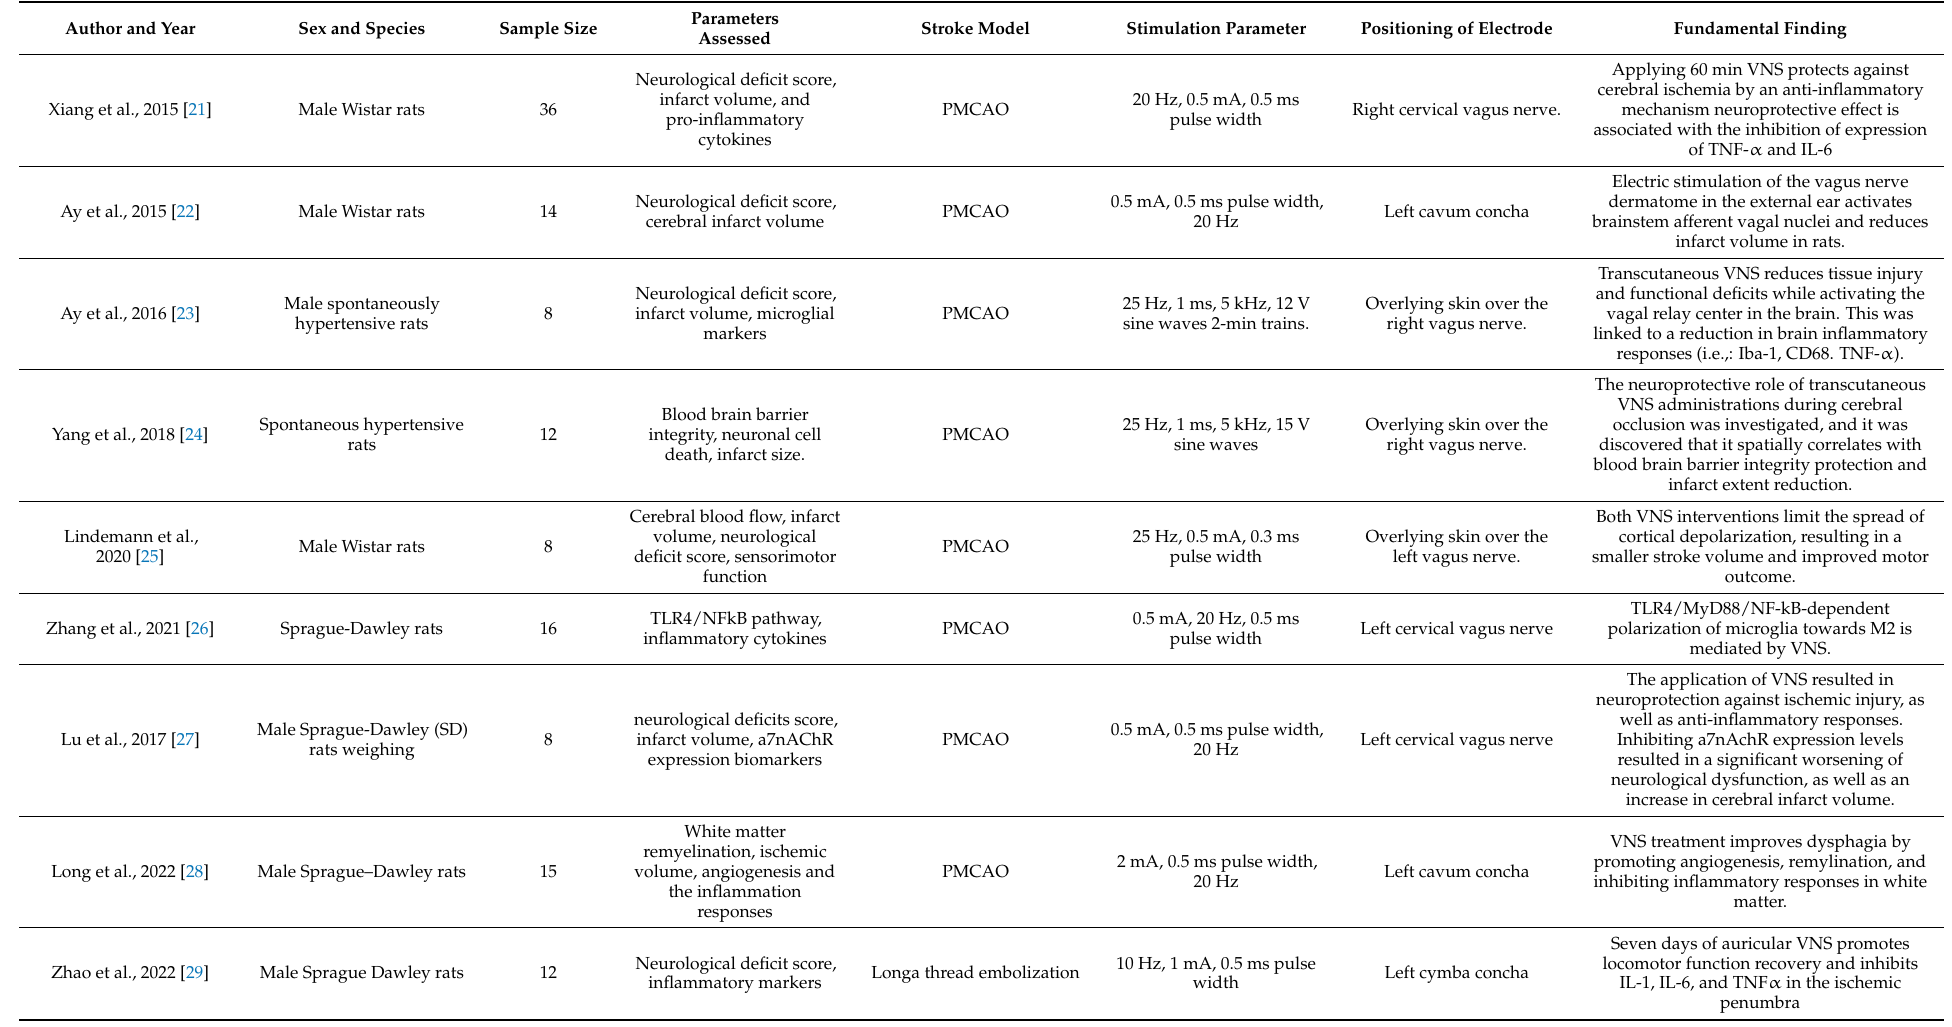
Table 2. Characteristics of the included